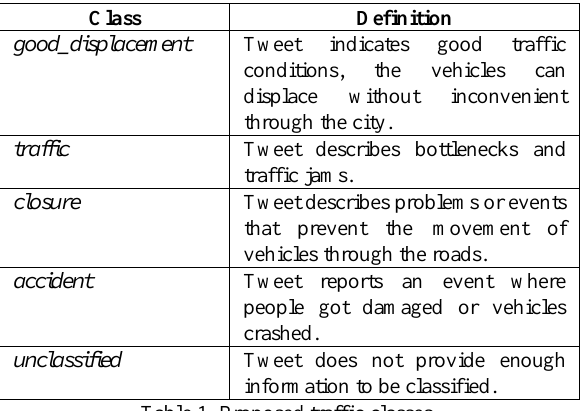
Algorithm 1.Creation of the words dictionary to analyse the content of